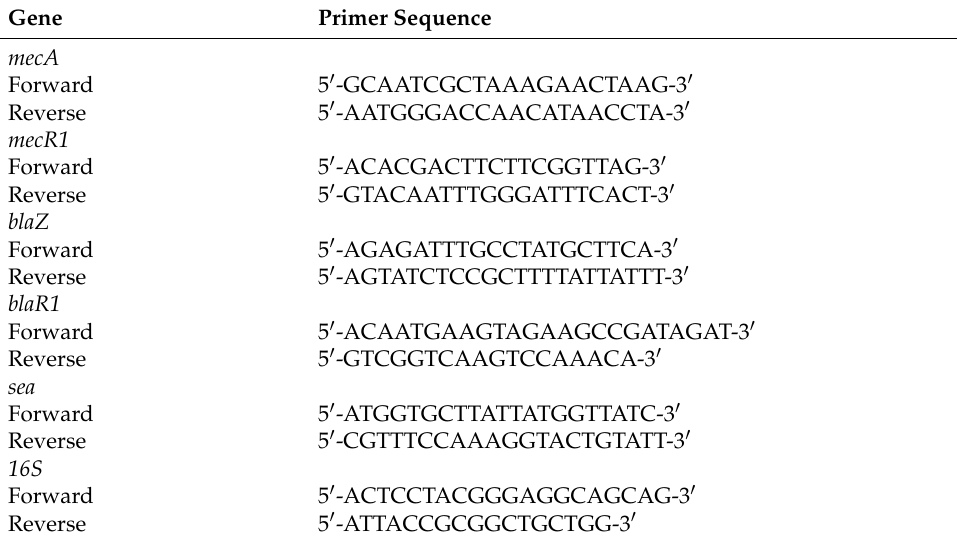
Table 3. Sequences of oligonucleotide primers designed for